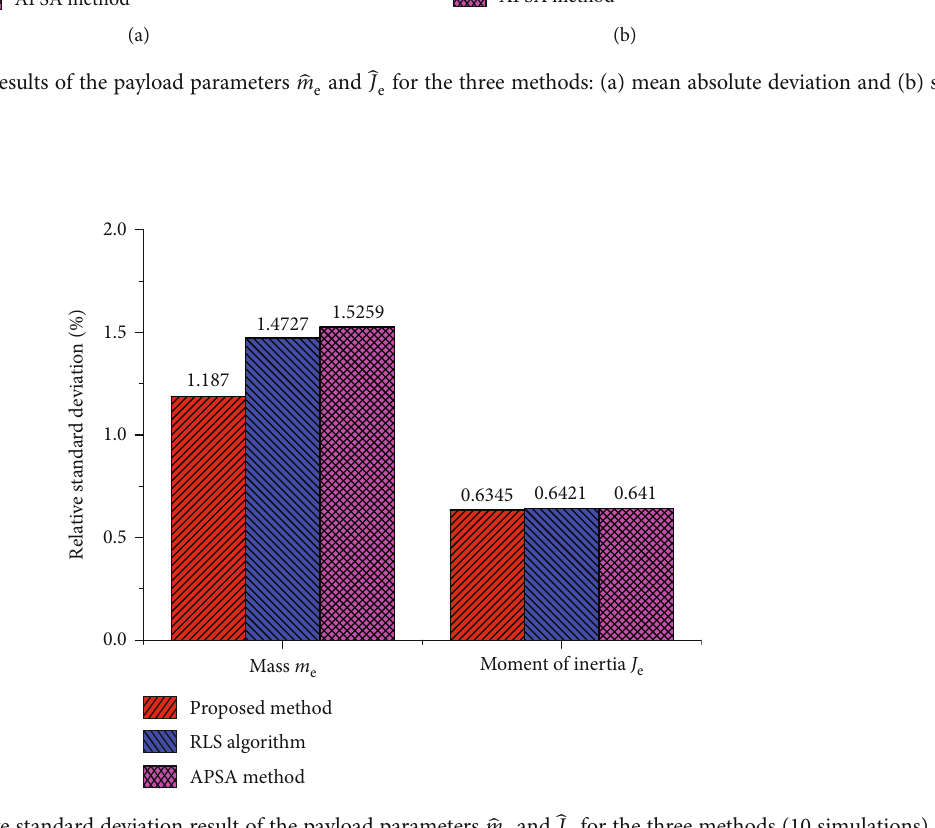
Figure 11: Relative standard deviation result of the payload parameters ̂ m